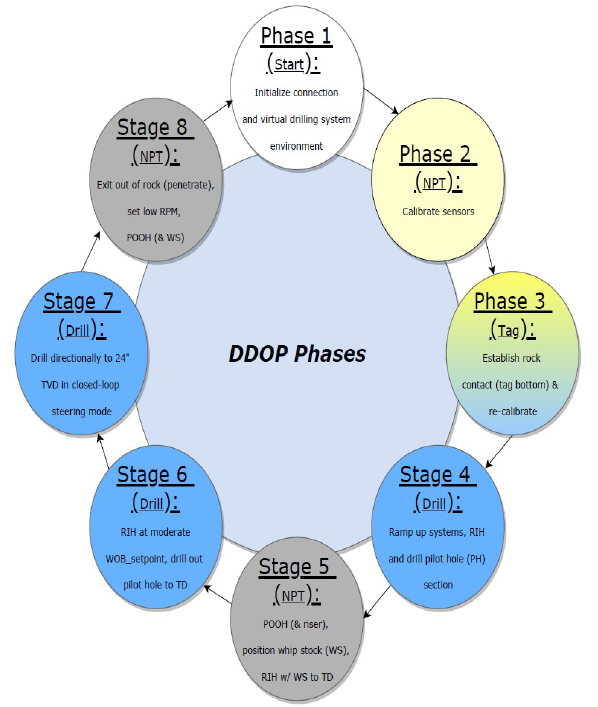
Figure 4: Eight phases constitute the digital direc- tional drilling